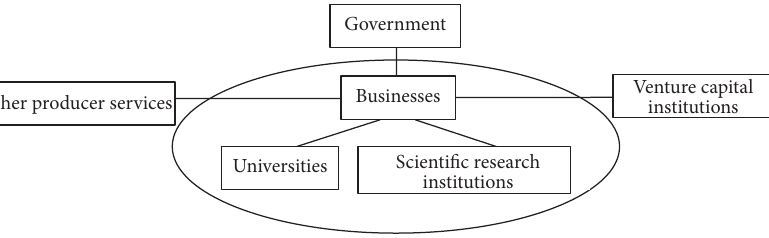
Figure 2: The ITISA consists of organizations from several different